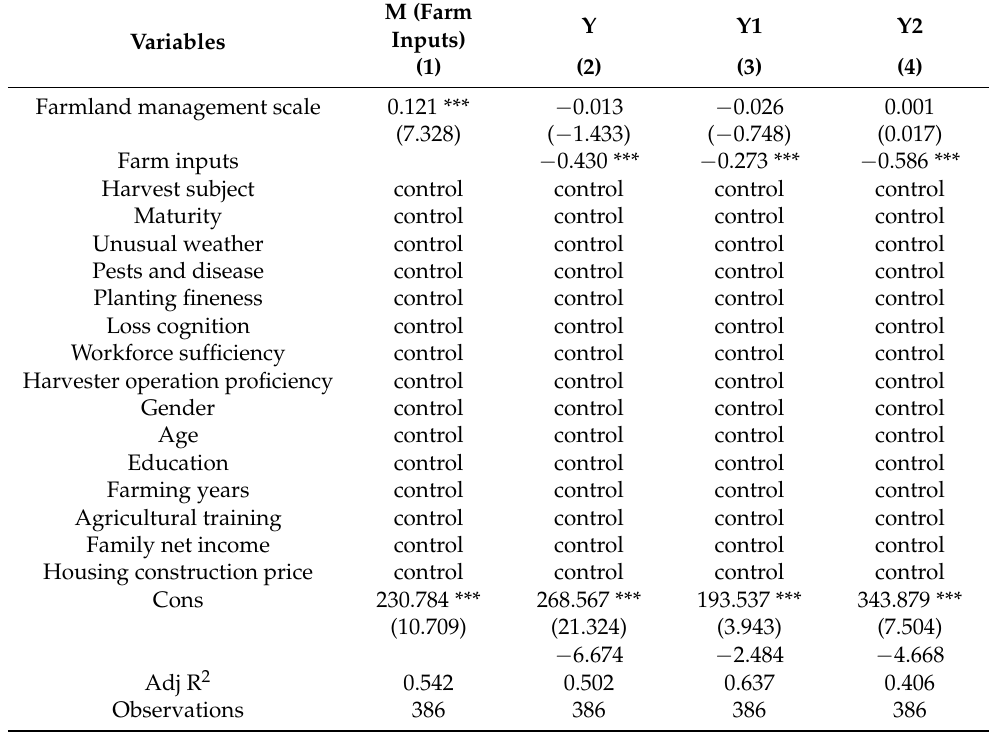
Table 6. Mediating effect of agricultural